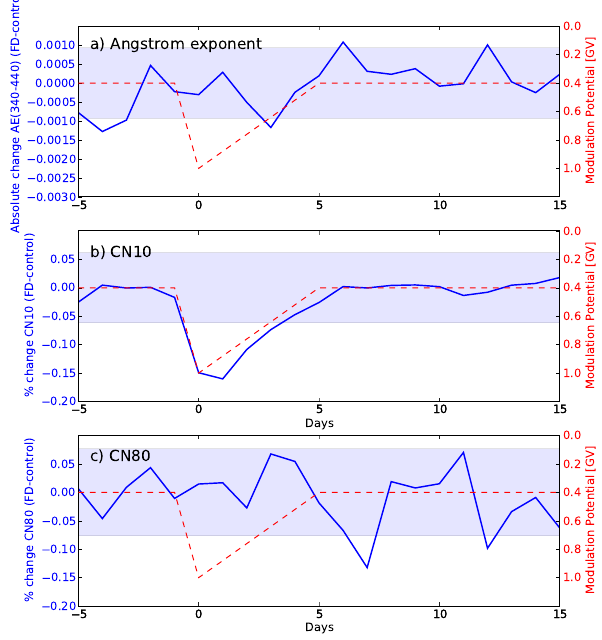
Fig. 9. Globally averaged change in the AE and percentage change in surface CN10, and CN80 as a function of time relative to the Forbush decrease with BASE model assumptions. 8 simulated Forbush-decrease events have been averaged together. Blue shaded region denotes 2 standard deviations of the data. Also shown in red is the simulated modulation potential as a function of time (right